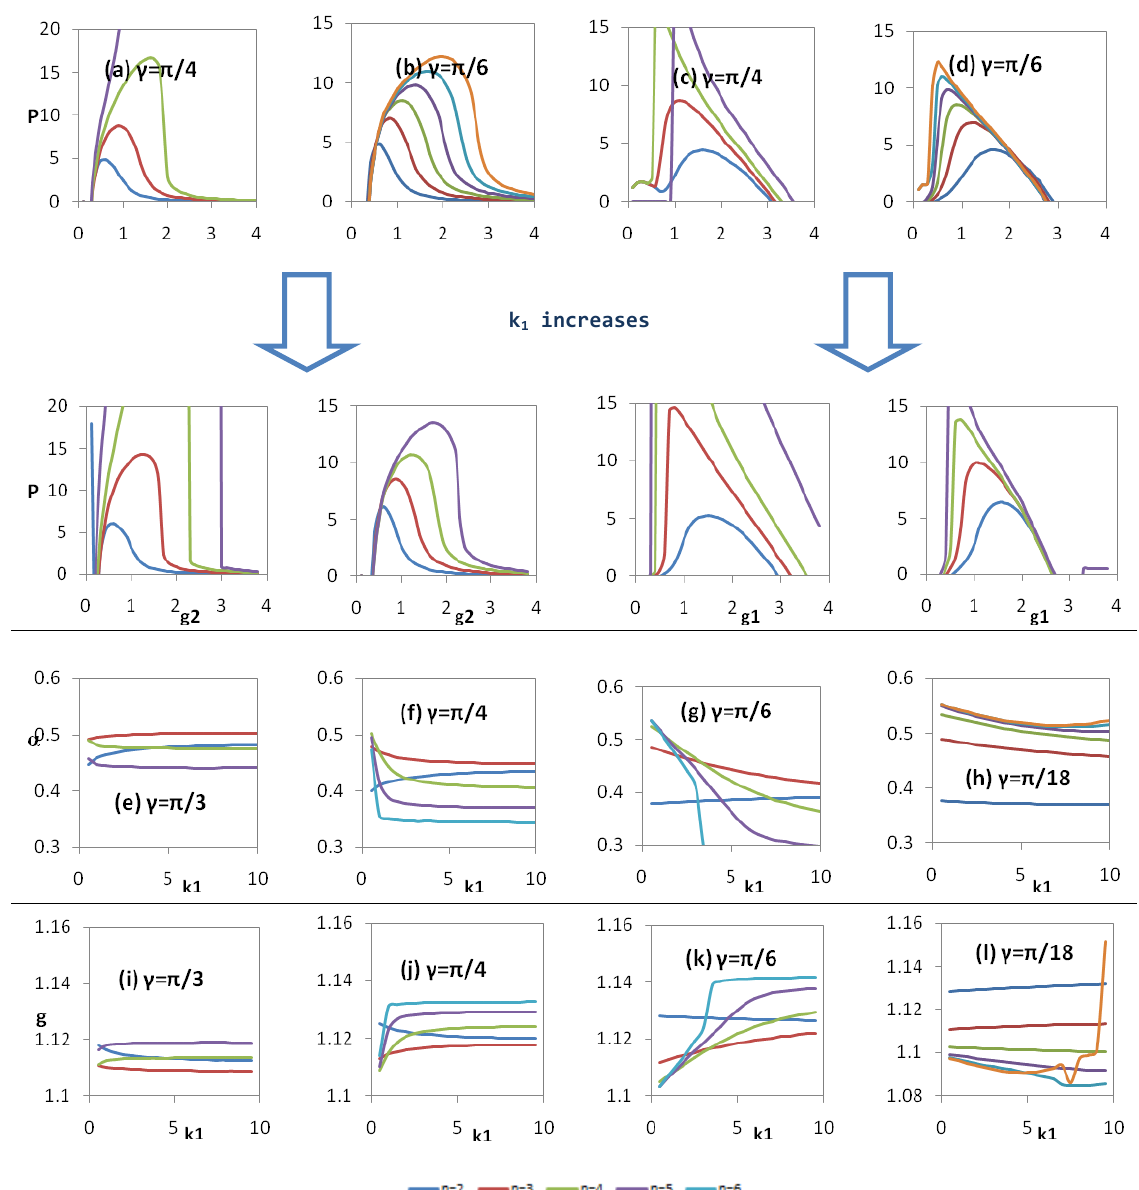
Figure 6: Effects of changing fiber density. One-layer model. µ =5kPa; k 2 =0.2; A=0.5, B=1.0. (a-d)Zero normal and shear stress boundary condition. Critical buckling pressure plotted against g 1 or g 2 . First row, k 1 =1.0; second row, k 1 = 3.0. (e-h) Enforced circular outer boundary condition. Critical buckling strain at inner boundary plotted against k 1 . (i-l) Fixed outer boundary. Critical buckling isotropic growth rate plotted against k 1 . Note how the trend of buckling mode aligns with enforced circular outer boundary